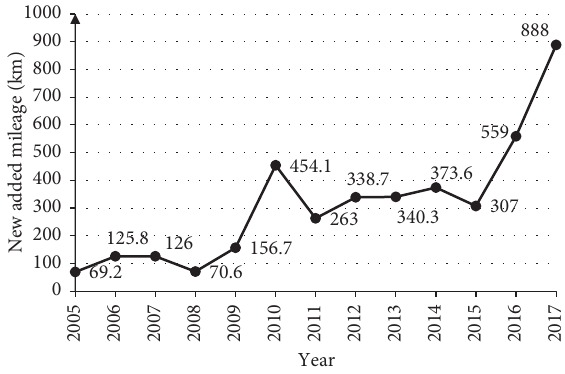
Figure 1: Newly added operating mileage from 2005 to